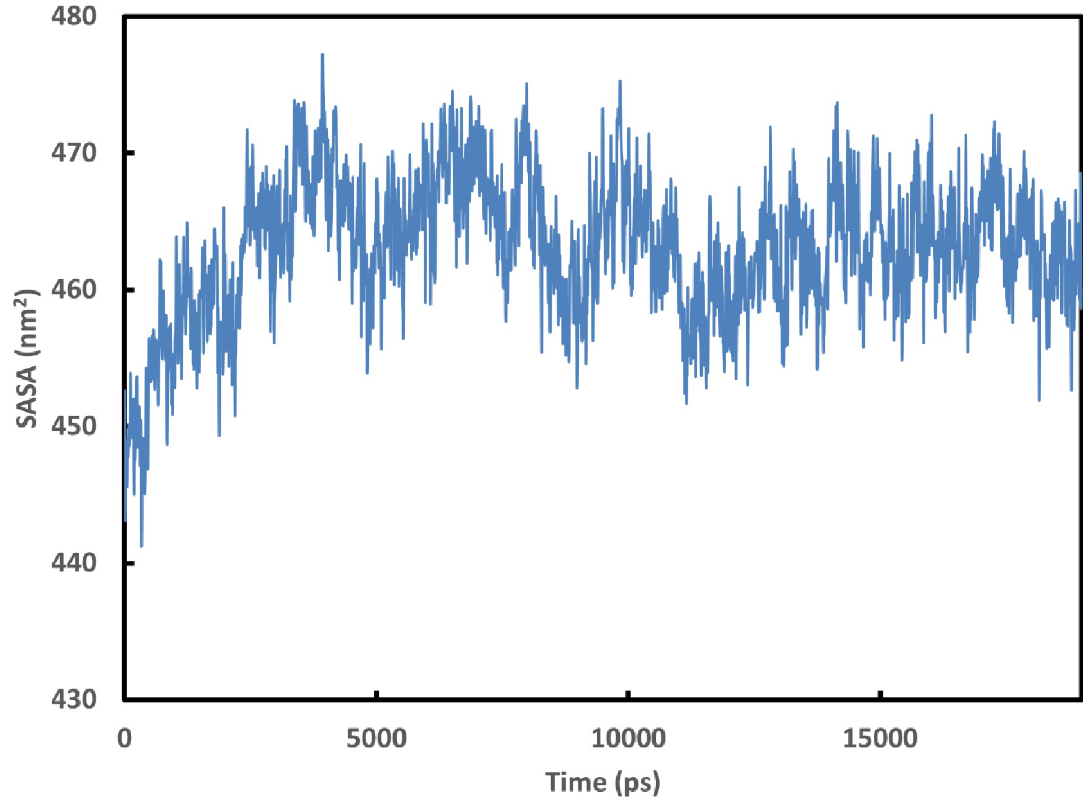
Fig 4. Graphs of SASA of RdRp as a function of time for a 19 ns simulation.